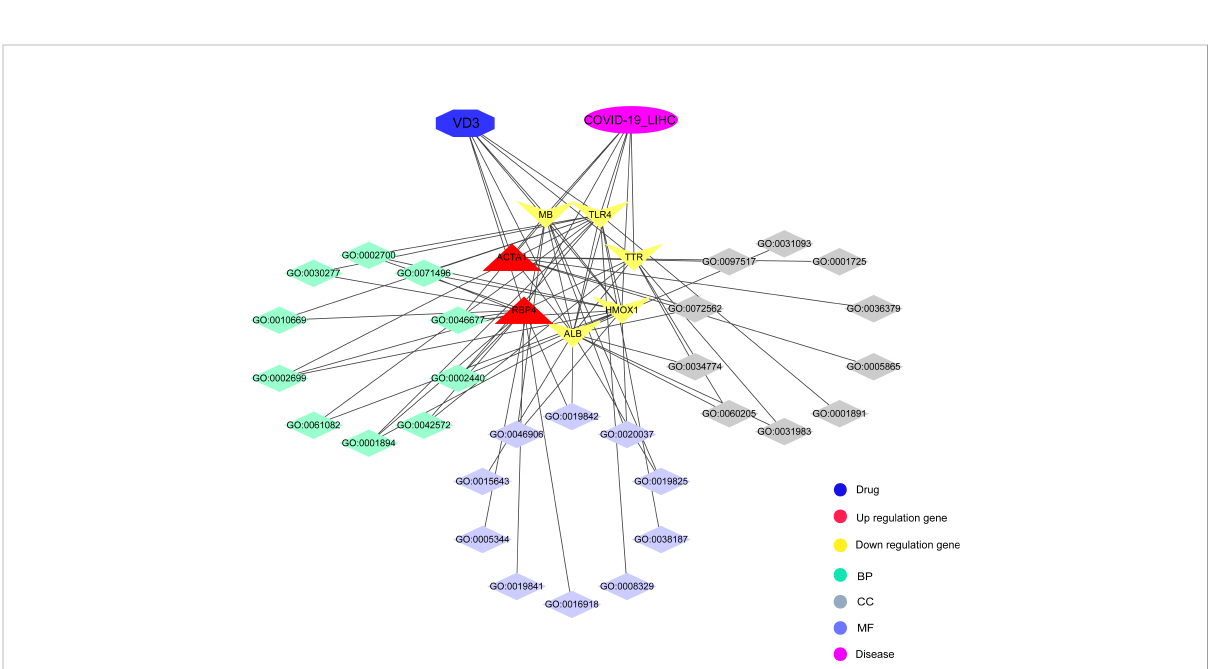
FIGURE 10 Interaction network for pharmacological targets and biological functions of vitamin D against